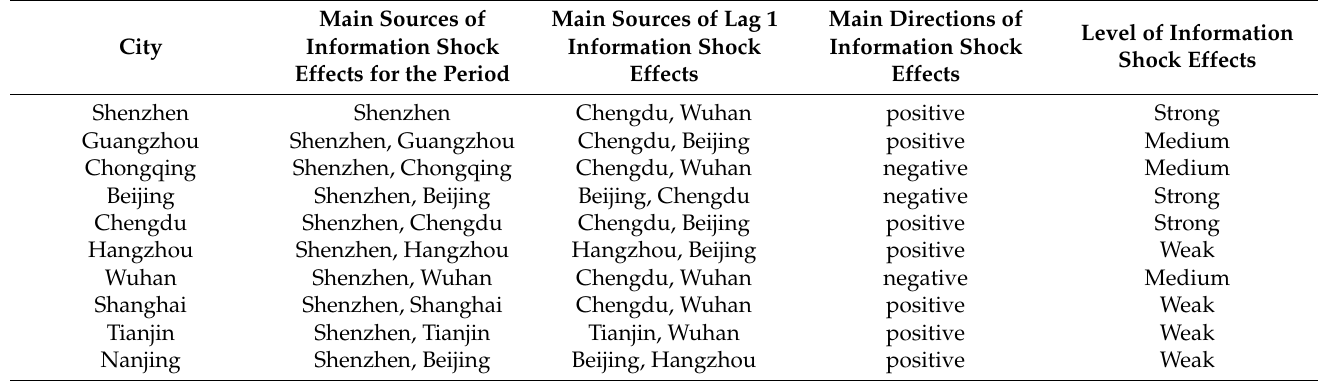
Table 6. State of dynamic impact of information impact on real estate market in various